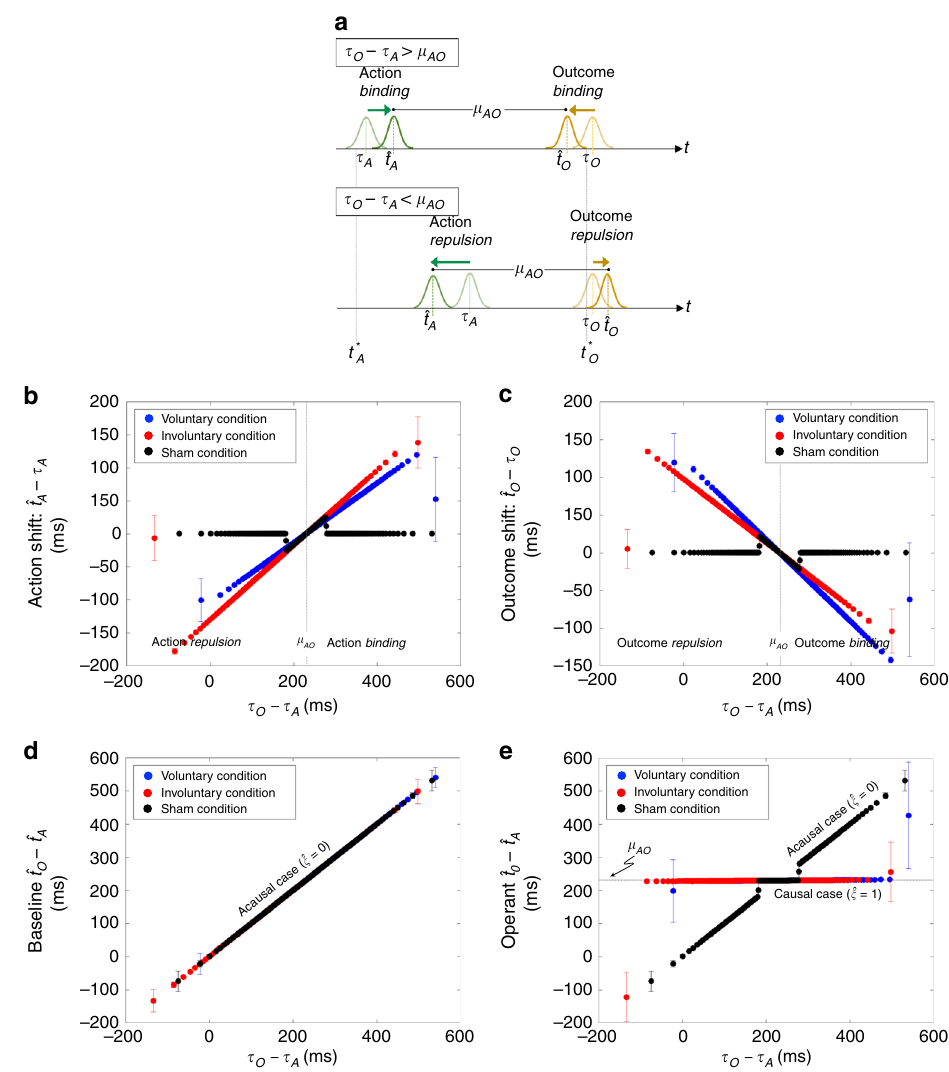
Fig. 3 Bayesian model predictions of trial-to-trial perceptual shifts and timing intervals. a Our Bayesian model predicts that (shown schematically) if τ − τ μ O A > AO action and outcome binding will happen. Otherwise, i.e., timings in the baseline move (compress or stretch) towards the temporal consistency ^ t there is positive perceptual shift in action awareness ( ^ t when τ O − τ A < μ AO . Both binding and repulsion occur in both voluntary and involuntary conditions, but very little effect in the sham condition. d The Bayesian estimates follow the sensory inputs in the baseline condition, i.e., τ Bayesian estimate shifts towards the prior assumption, ^ t and therefore when causality is detected ( ^ ξ = 1). Otherwise, the estimate of action and outcome timings follow the sensory inputs. The fi tted causal prior P ( ξ = 1) is 0.9, 0.9, and 0.1 for the voluntary, involuntary, and sham conditions, respectively (as in Fig. 2). The per-trial results are grouped accordingly into bins of width 200 (randomly chosen), and the mean and SD for each bin are plotted. This format is followed each time a quantity of interest is plotted as